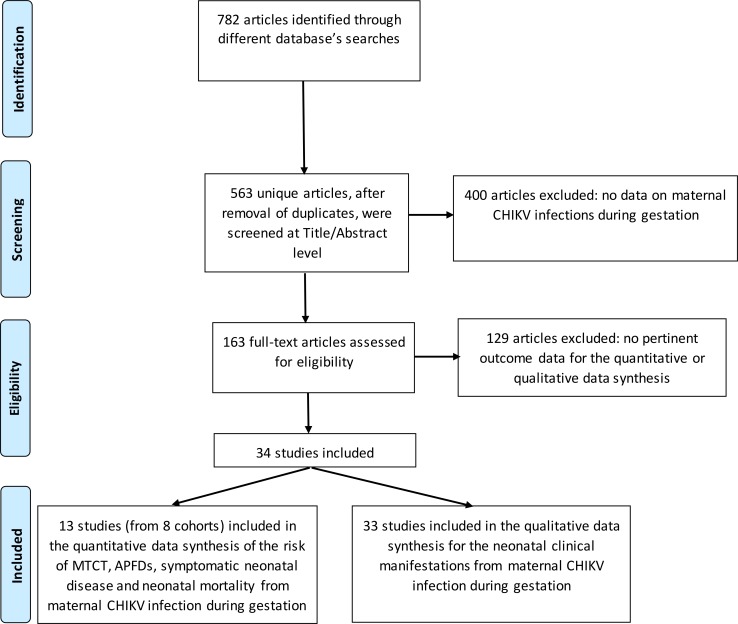
PRISMA flow diagram.(Abbreviations: APFD: Antepartum Fetal Deaths, CHIKV: Chikungunya Virus, MTCT: Mother-To-Child Transmission).